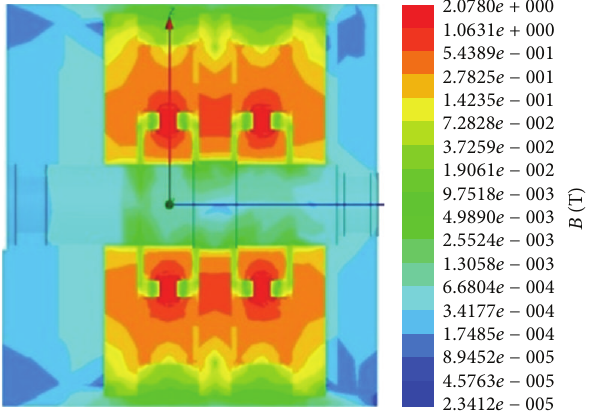
Figure 6: Results of magnetic induction strength on the selected